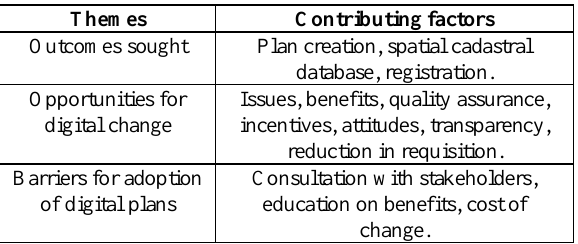
Table 1 : Key Themes for Low Adoption of LandXML